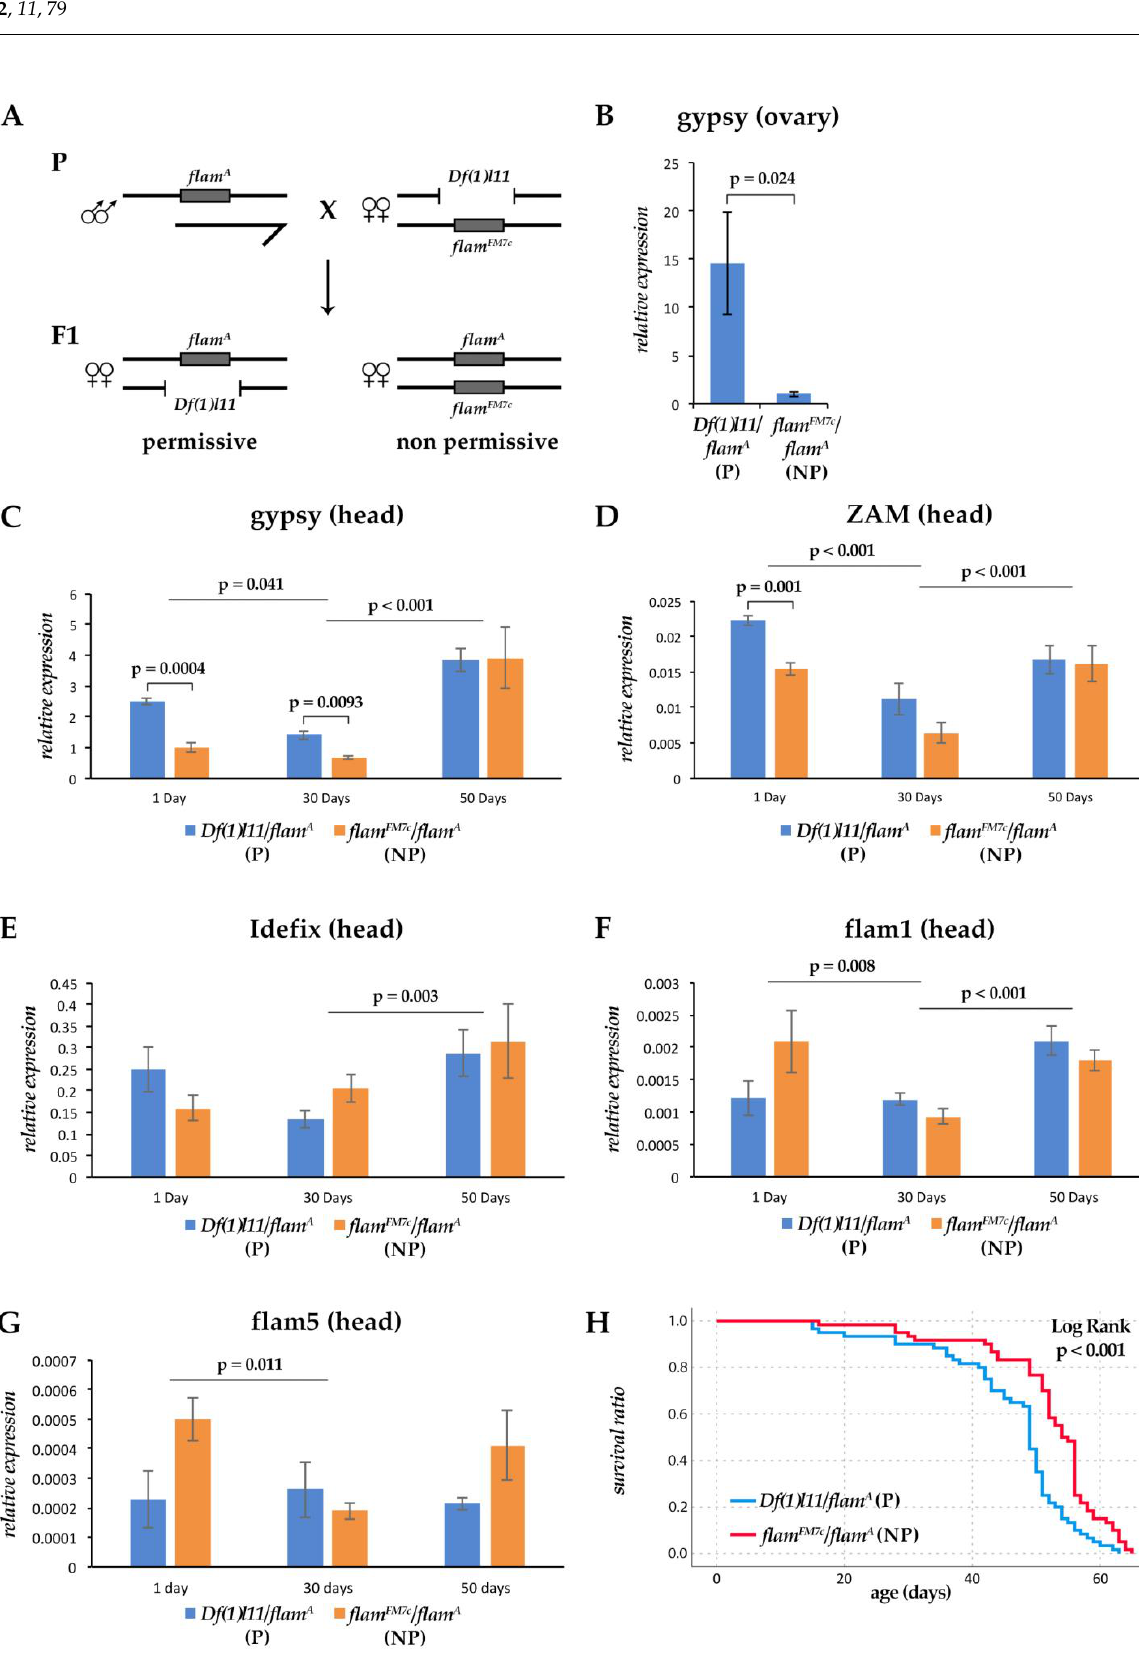
Figure 2. Analysis of the expression of the selected retrotransposons and of flamenco in aging. ( A ) Schematic representation of the genetic cross performed to obtain individuals permissive and non-permissive for the activation of gypsy . ( B ) Analysis of the expression of gypsy in RNAs isolated from 3-days-old ovaries of flam A /Df(1)l11 and flam A /flam FM7 adult females. The fold changes indicate the expression levels relative to calibrator ( flam A / flam FM7 ) ( C – F ) Gene expression